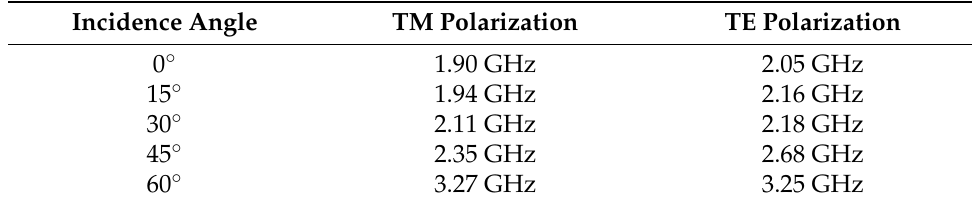
Table 1. Bandwidth